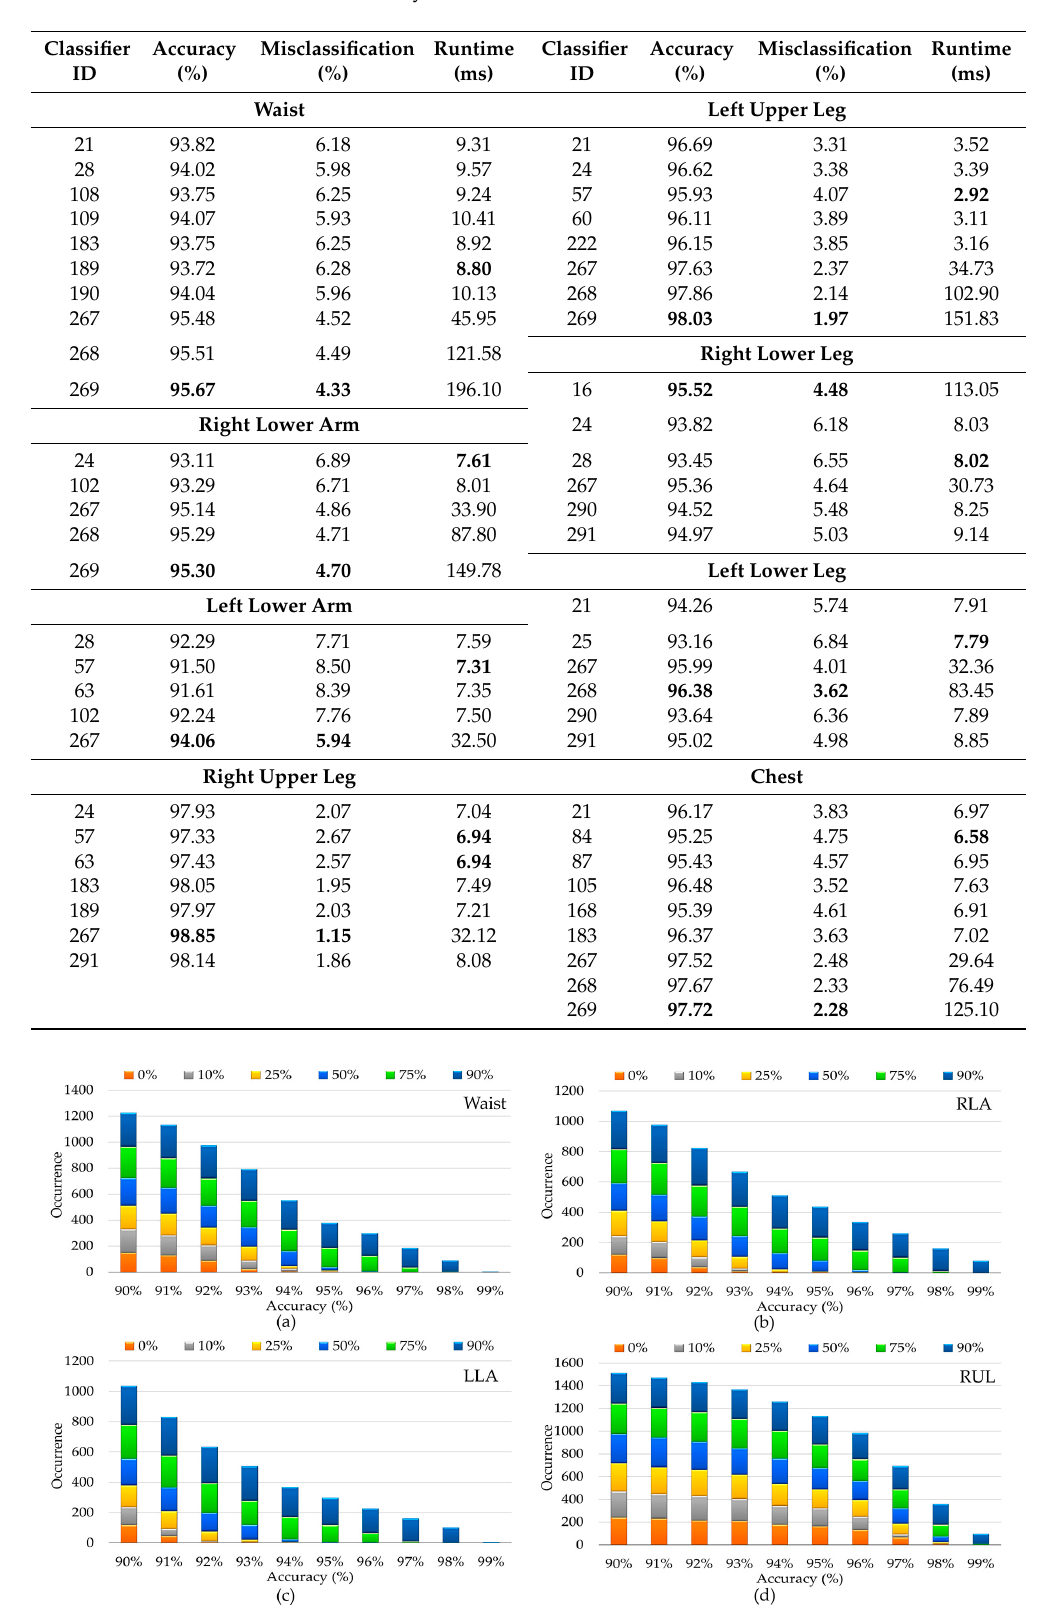
Table 3. The accuracy and runtime of non-dominated classifiers.